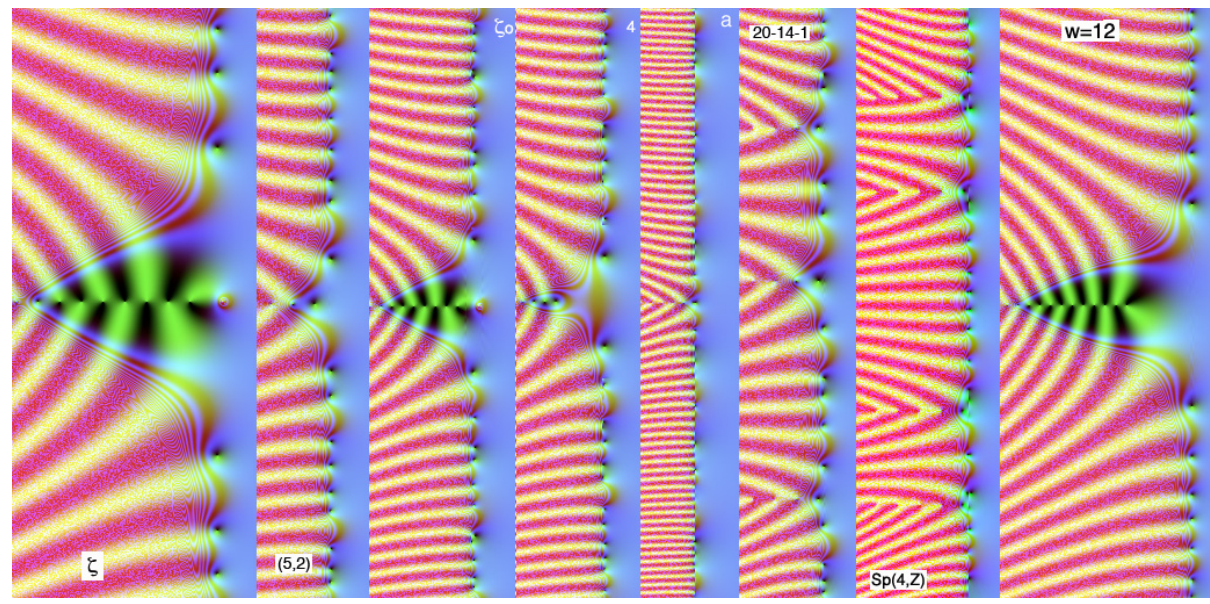
Figure 13: A menagerie of L-functions: Riemann zeta, a Dirichlet L-function modulo 5, Dedekind zeta and a Hecke L-function of the complex primes of the Gaussian integers as an extension field, the L-function of the elliptic curve y 2 + x y = x 3 + x 2 − 210 x − 441 , third and fourth degree Maass forms and the modular discriminant all appear to have their non-trivial zeros on their weighted critical line, but so far have not shed new light on Riemann hypothesis